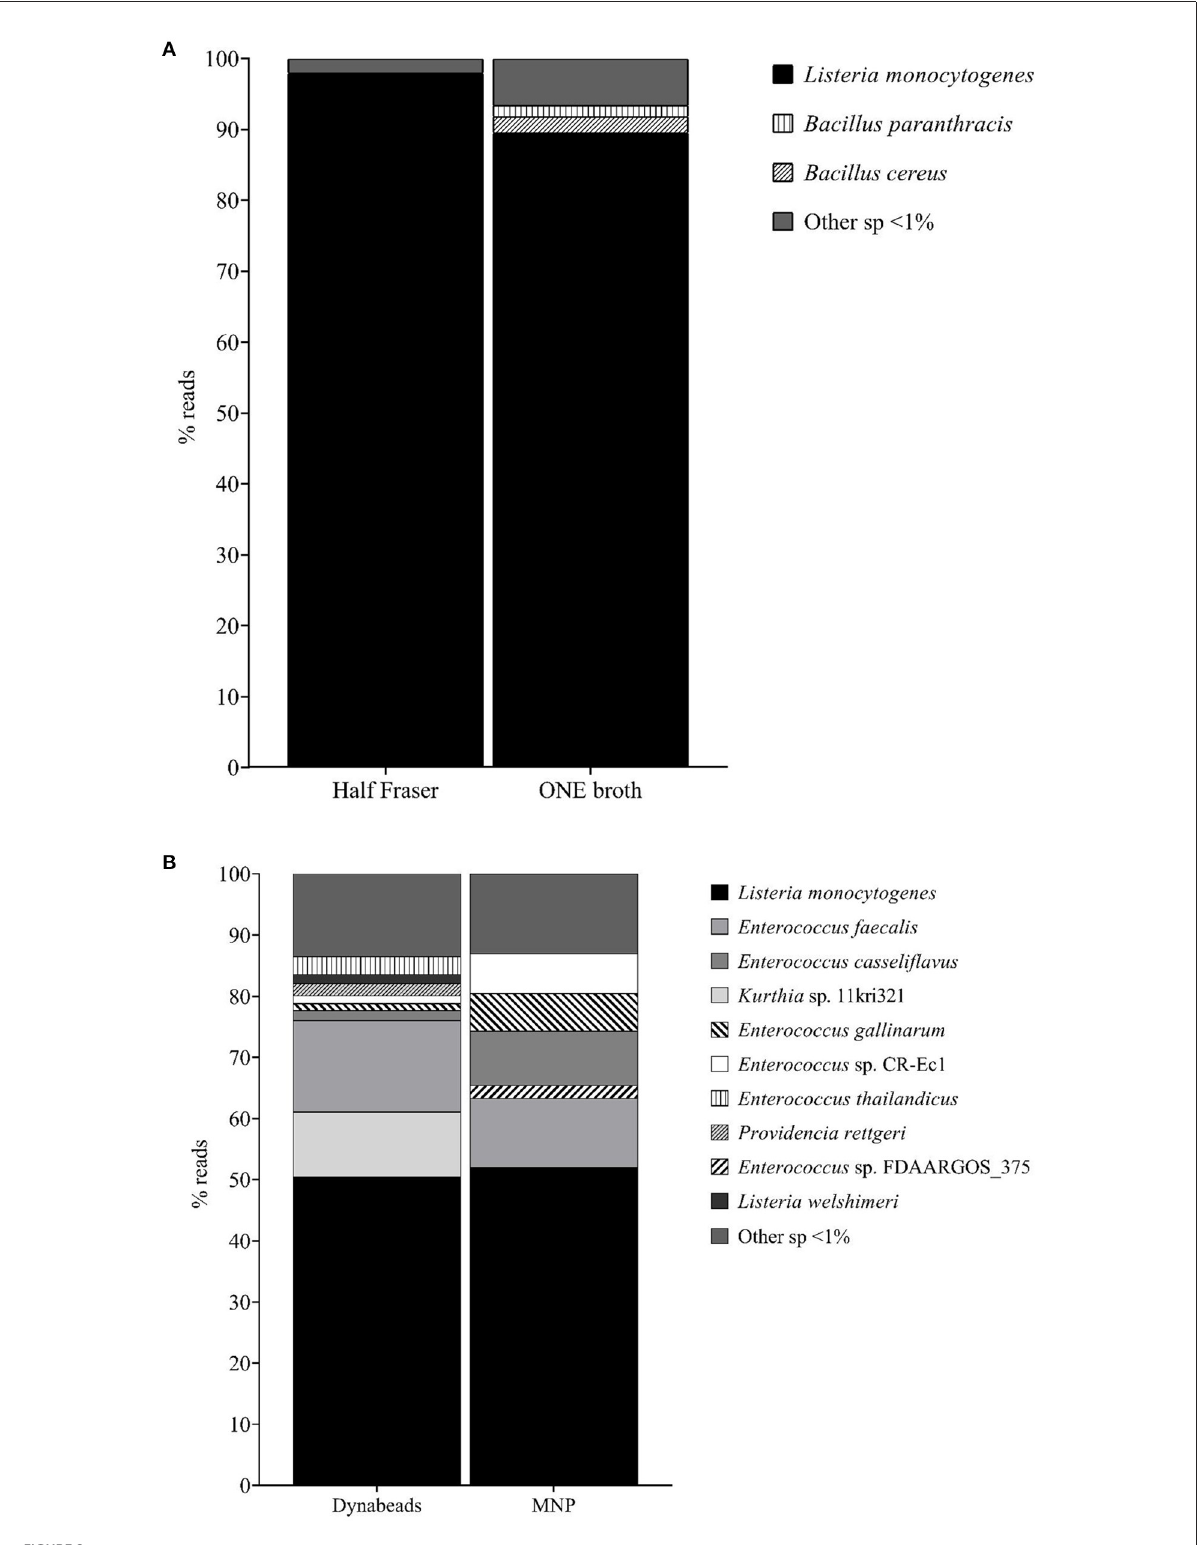
FIGURE2 (A) Percentage reads obtained by WIMP in the evaluation of the two “primary enrichment” broths, HF and ONE. (B) Percentage reads obtained by WIMP in the evaluation of the two “IMS” approaches, Dynabeads ® anti- Listeria and MNP with the